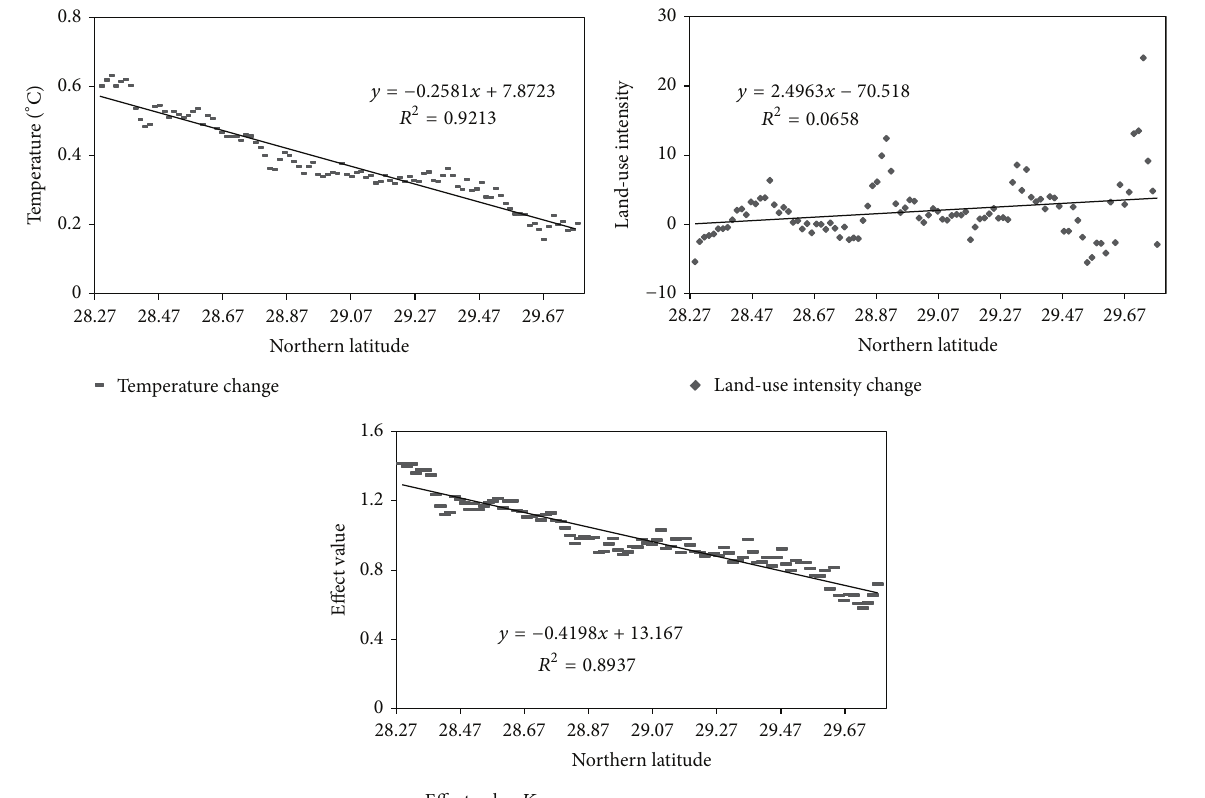
Figure 9: Latitudinal effects on land-use intensity and temperature from 2001 to